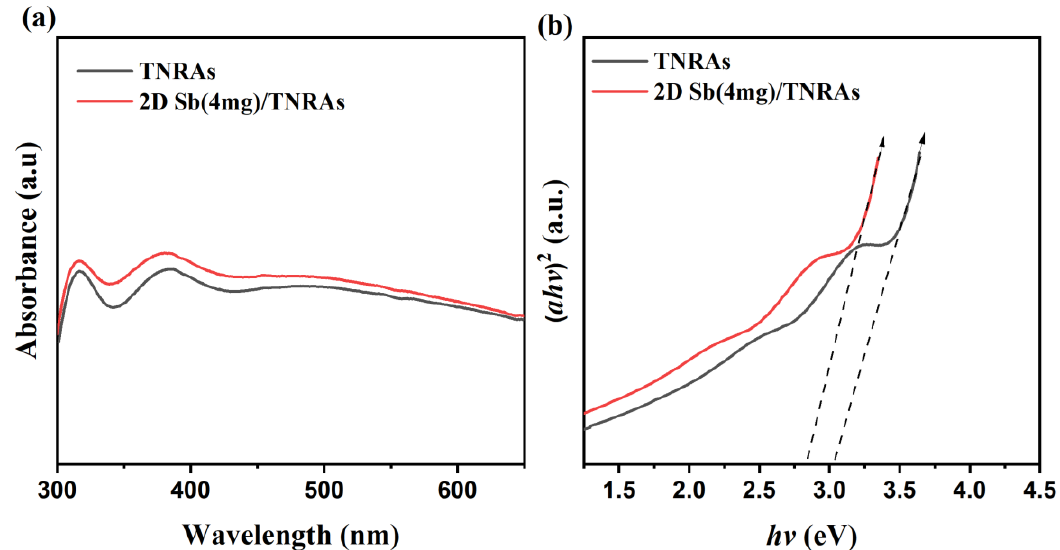
Figure 4. ( a ) UV-Vis absorption spectra of TiO 2 NRAs and 2D Sb (4 mg)/TiO 2 NRAs. ( b ) Tauc plots from the UV–Vis spectra of TiO 2 NRAs and 2D Sb (4 mg)/TiO 2 NRAs. TNRAs: TiO 2